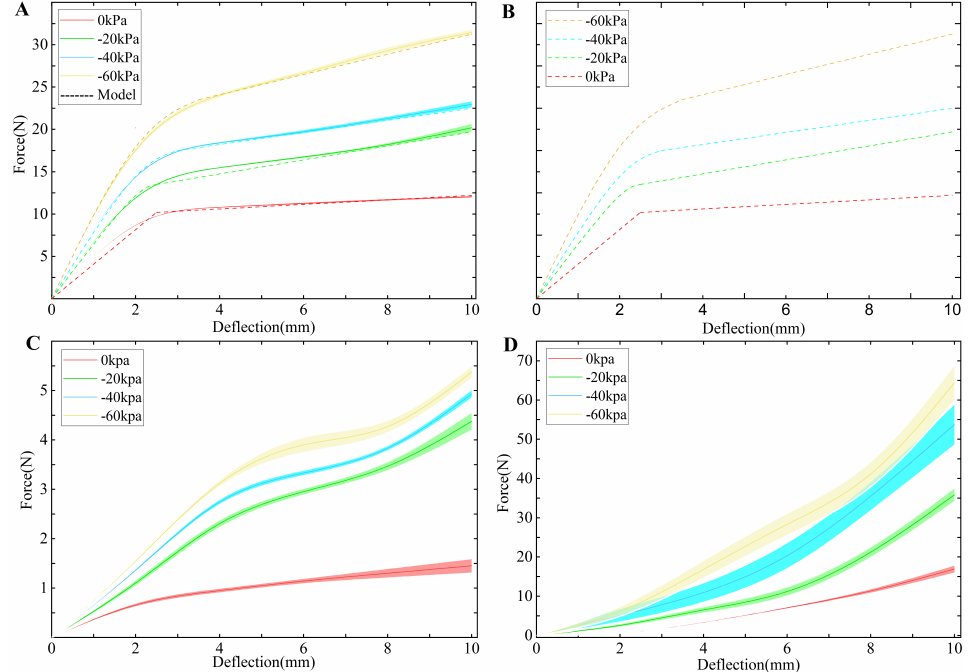
Figure 4. Mechanical characterization of TSCR from 0 kPa to − 60 kPa. Each solid line represents the average behavior of the TSCR. Clouds indicate 1 SD from the mean. ( A ) Lateral bending experiment at 90°. Dashed lines are predictions from the analytical model. ( B ) Dashed lines are predictions from the finite element. ( C ) Lateral bending experiment at 0°. ( D ) Compression experiment with straight